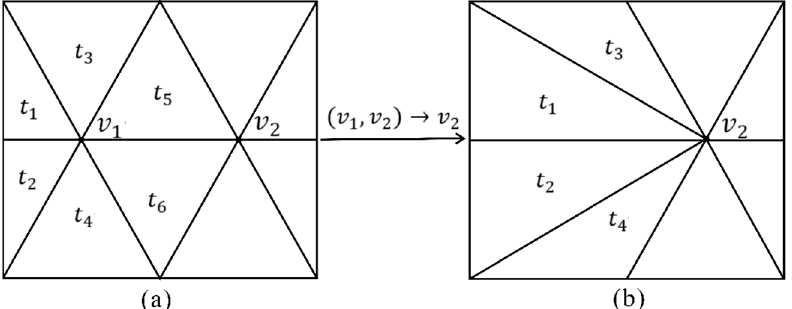
Figure 1. Schematic diagram of the mesh simplification, in which vertex v 1 is deleted, vertex v 2 replaces v 1 as the vertex of triangular patches t 1 – t 4 , and triangular patch t 5 is deleted. ( a ) Unsimplified mesh. ( b ) Simplified mesh.